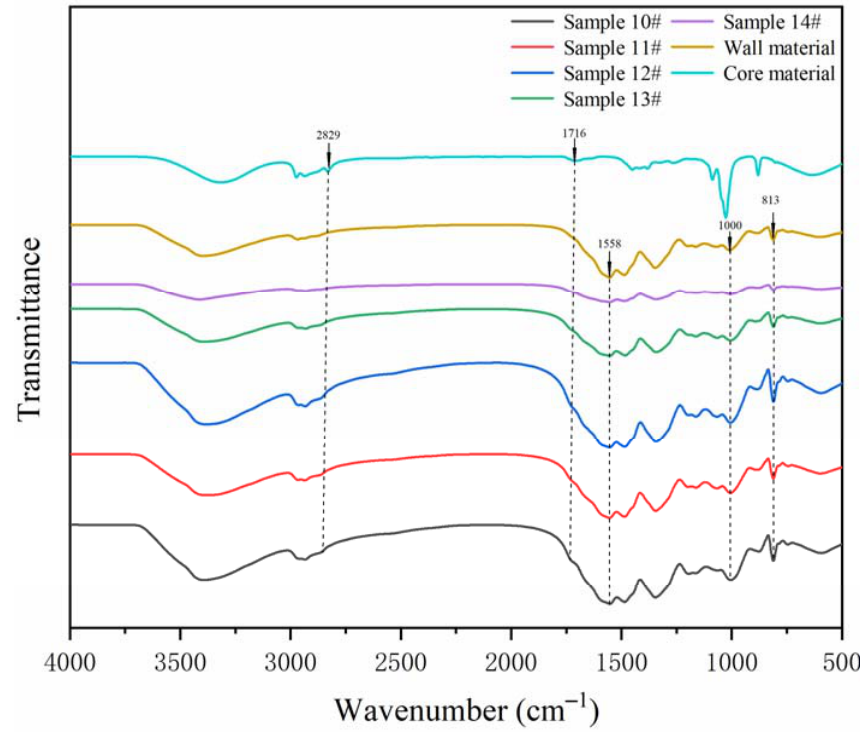
Figure 10. The FTIR of the microcapsules in single-factor tests.